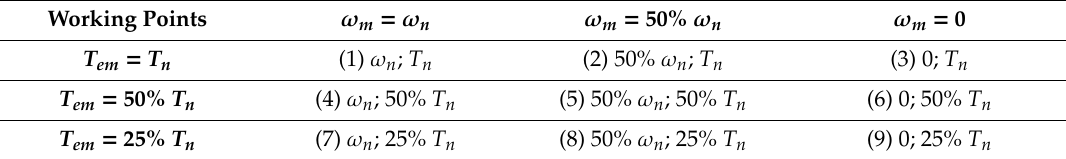
Table 8. IPMSM Working